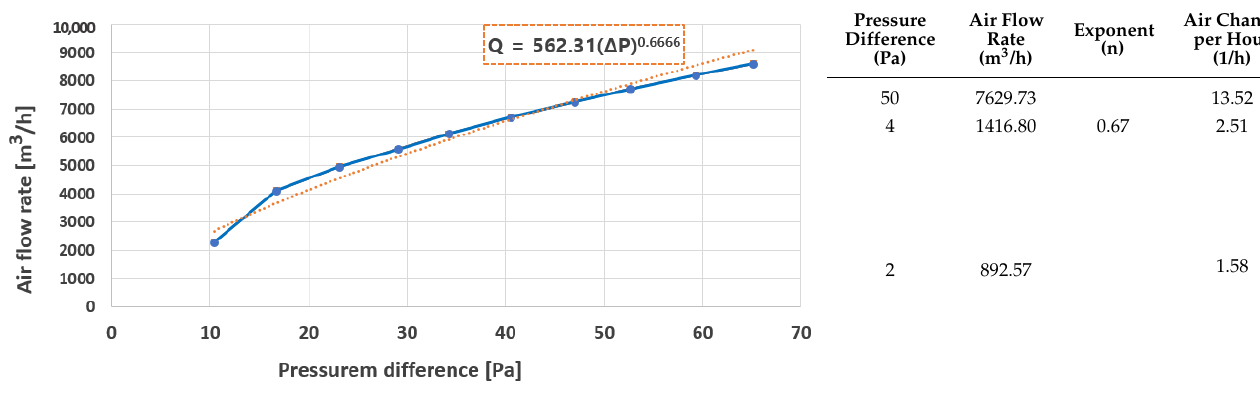
Table 6. Change in the air flow rate per hour of the MPA-space of D elementary